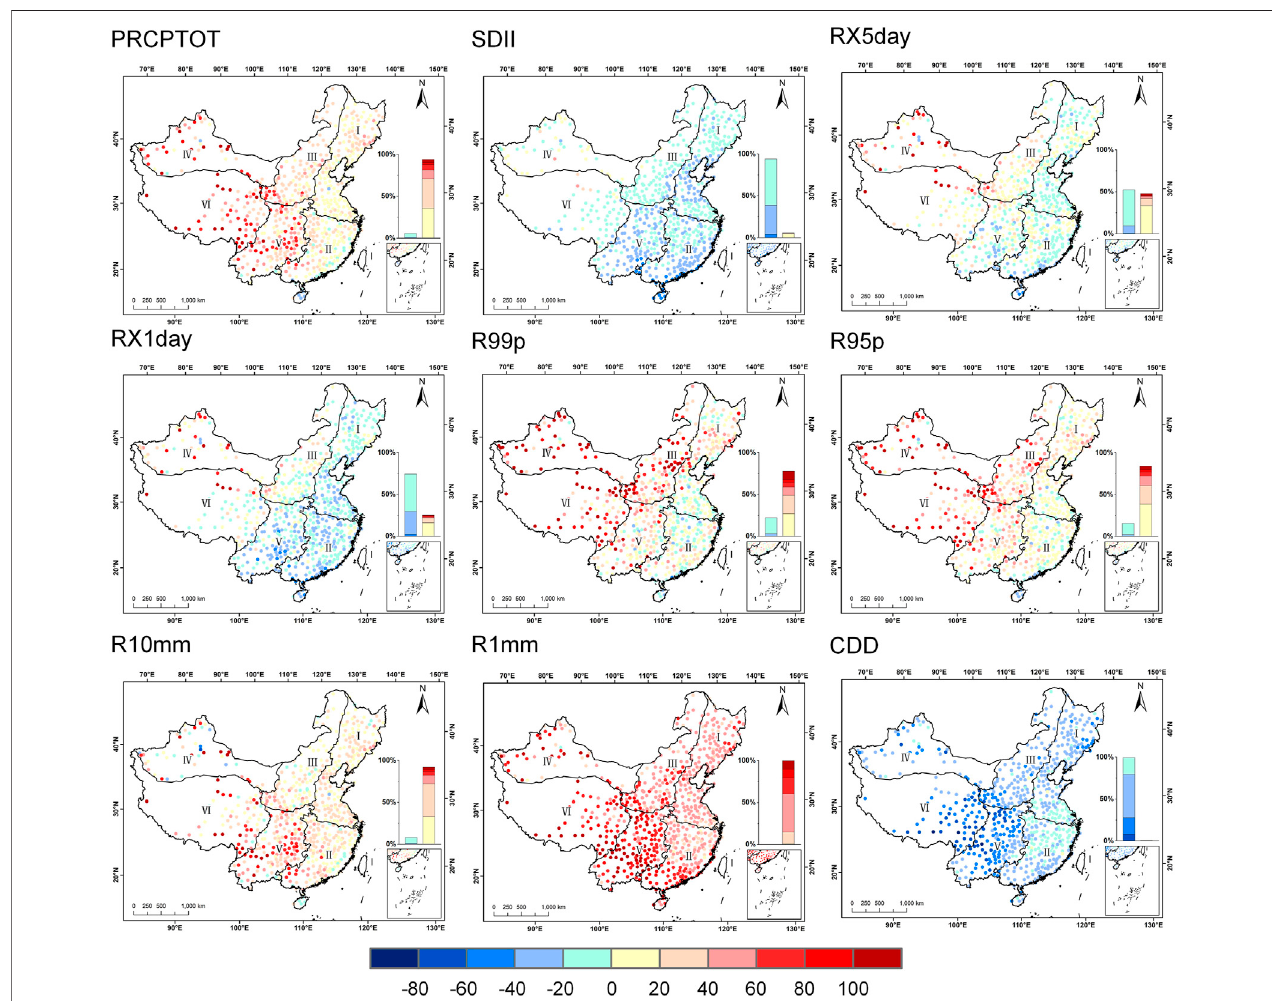
FIGURE 4 | Spatial distribution of RB (%) for extreme precipitation indices of ERA5 over